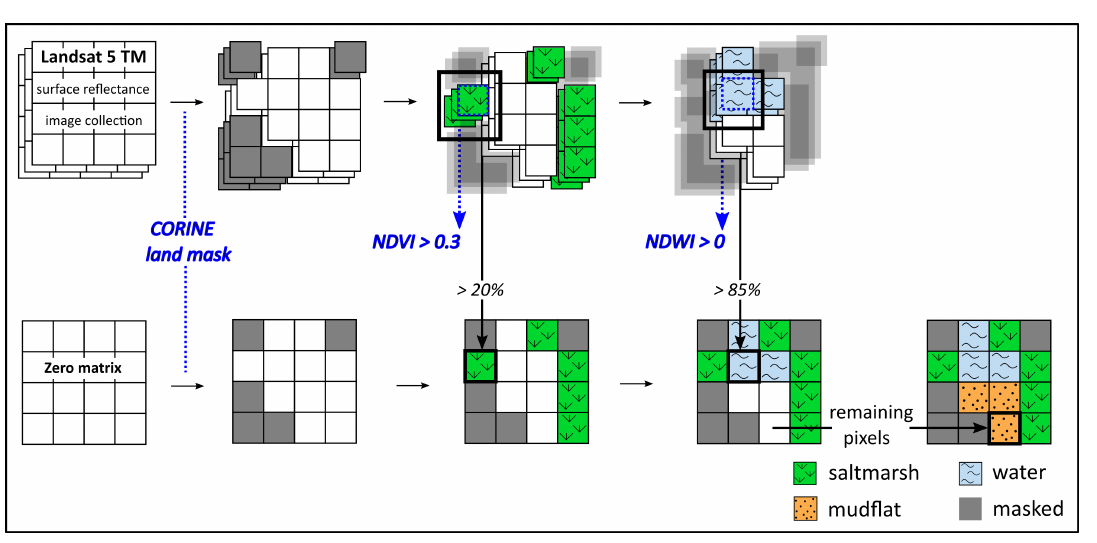
Figure 2. Unsupervised decision tree classification procedure in Google Earth Engine performed for each time step in the time series of each study site. A classified image results from a Landsat 5 TM surface reflectance image collection of three years. The classification result defines the classes saltmarsh vegetation, mudflat, and open